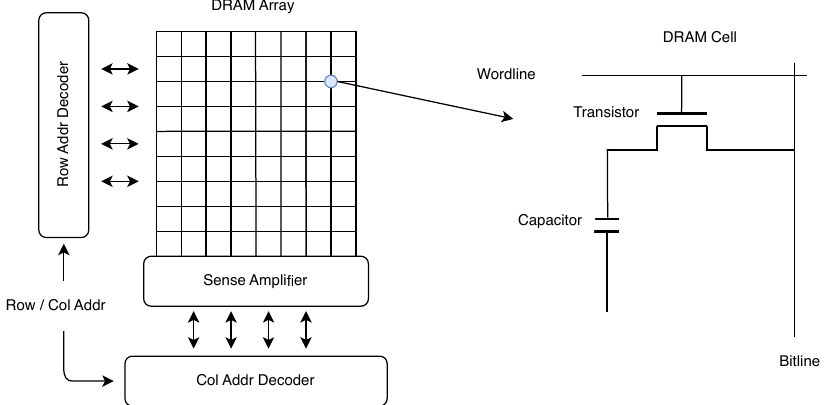
Figure 4. The structure of DRAM Array and DRAM